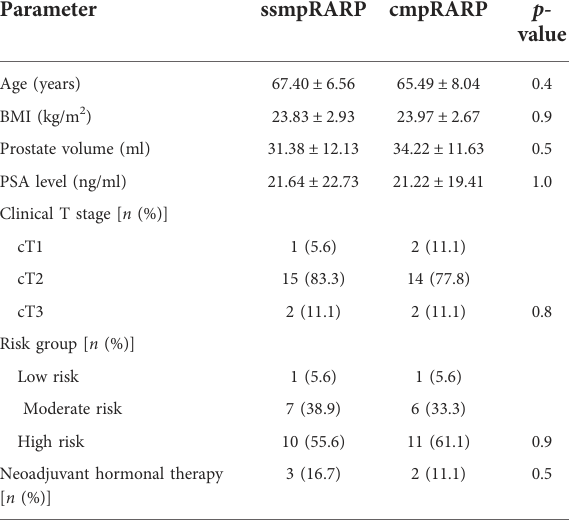
TABLE 1 Demographics and preoperative characteristics. TABLE 2 Perioperative, pathologic, and early follow-up